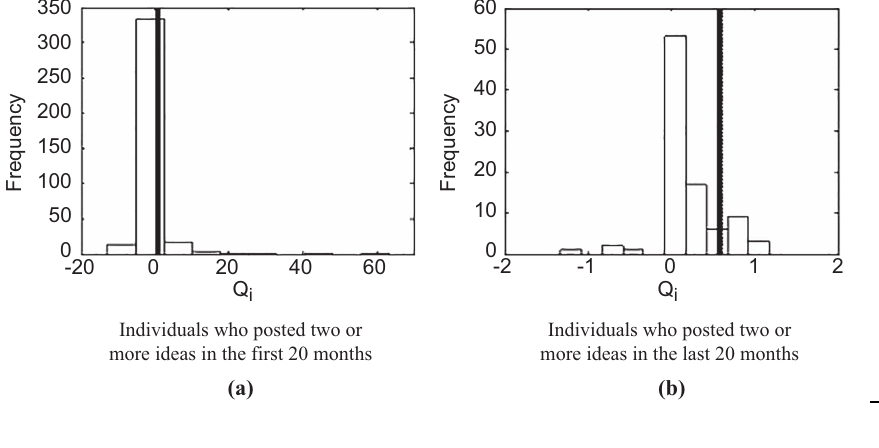
Figure 4. Distributions of the average value of individuals in the two